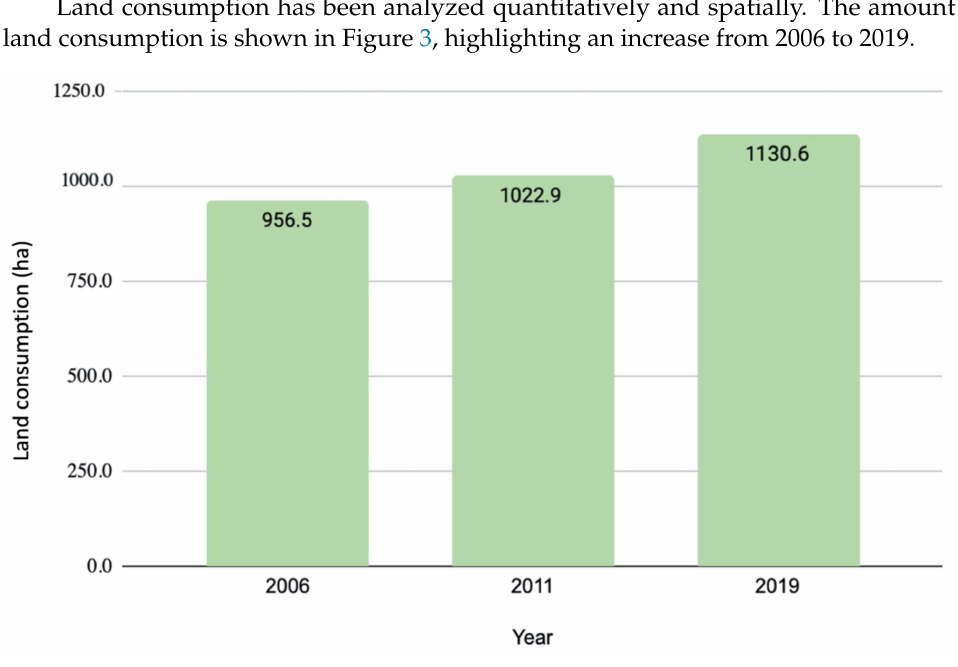
Figure 3. Estimated annual land consumption (ha) for the years 2006, 2011, and